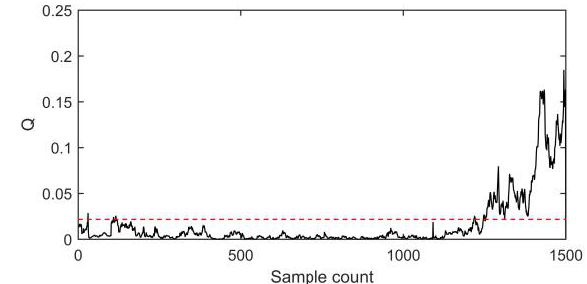
Figure 4. The Q -statistic of EVT based on the PCA model.